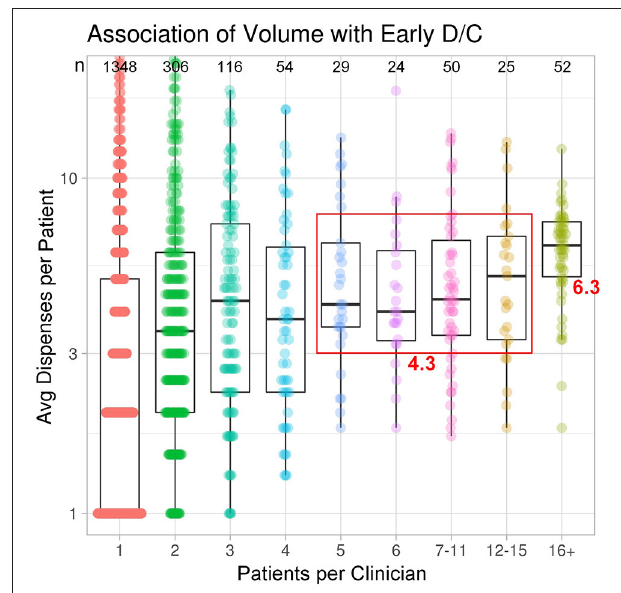
FIGURE 2 | Treatment variability and early discontinuation increased with decreased patient volume. Improved adherence to treatment was noted